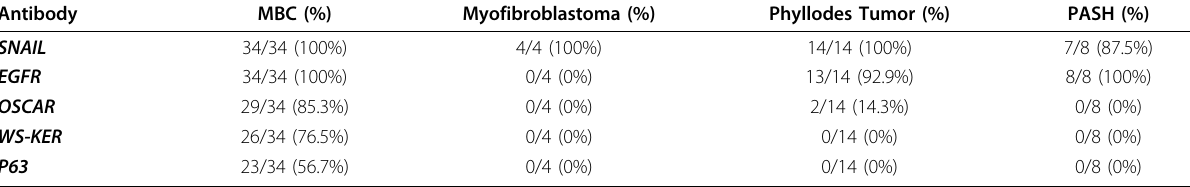
Table 3 Immunoexpression of the different markers in MBC, myofibroblastomas phyllodes tumor, and PASH Antibody MBC (%) Myofibroblastoma (%) Phyllodes Tumor (%)